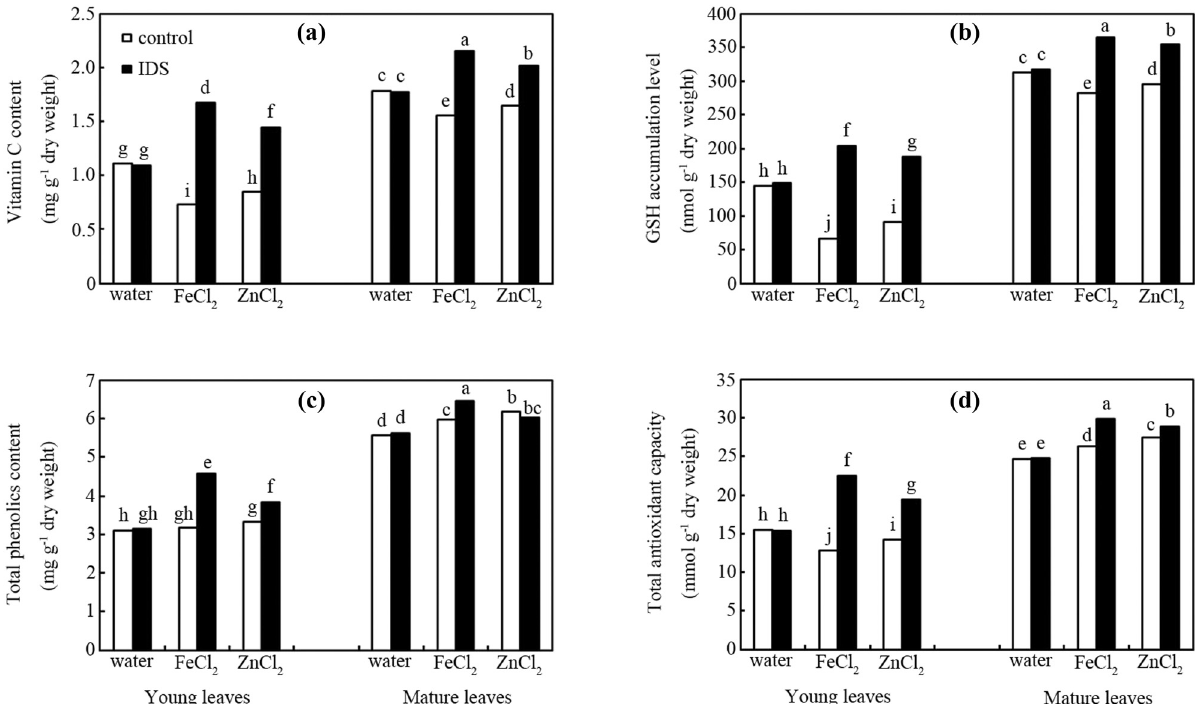
Figure 3: Antioxidant nutrient in jujube leaves. E ff ects of foliar spraying with mineral element fertilizer in the ionic ( FeCl 2 and ZnCl 2 ) and chelate ( Fe - IDS and Zn - IDS ) forms on ( a ) vitamin C level, ( b ) GSH accumulation, ( c ) total phenolic content, and ( d ) total antioxidant capacity were monitored in the young and mature leaves of jujube after treatment for 7 days. Mean values assigned with the same letter are not signi fi cantly di ff erent ( n = 3; p < 0.05 ) . IDS, iminodisuccinic